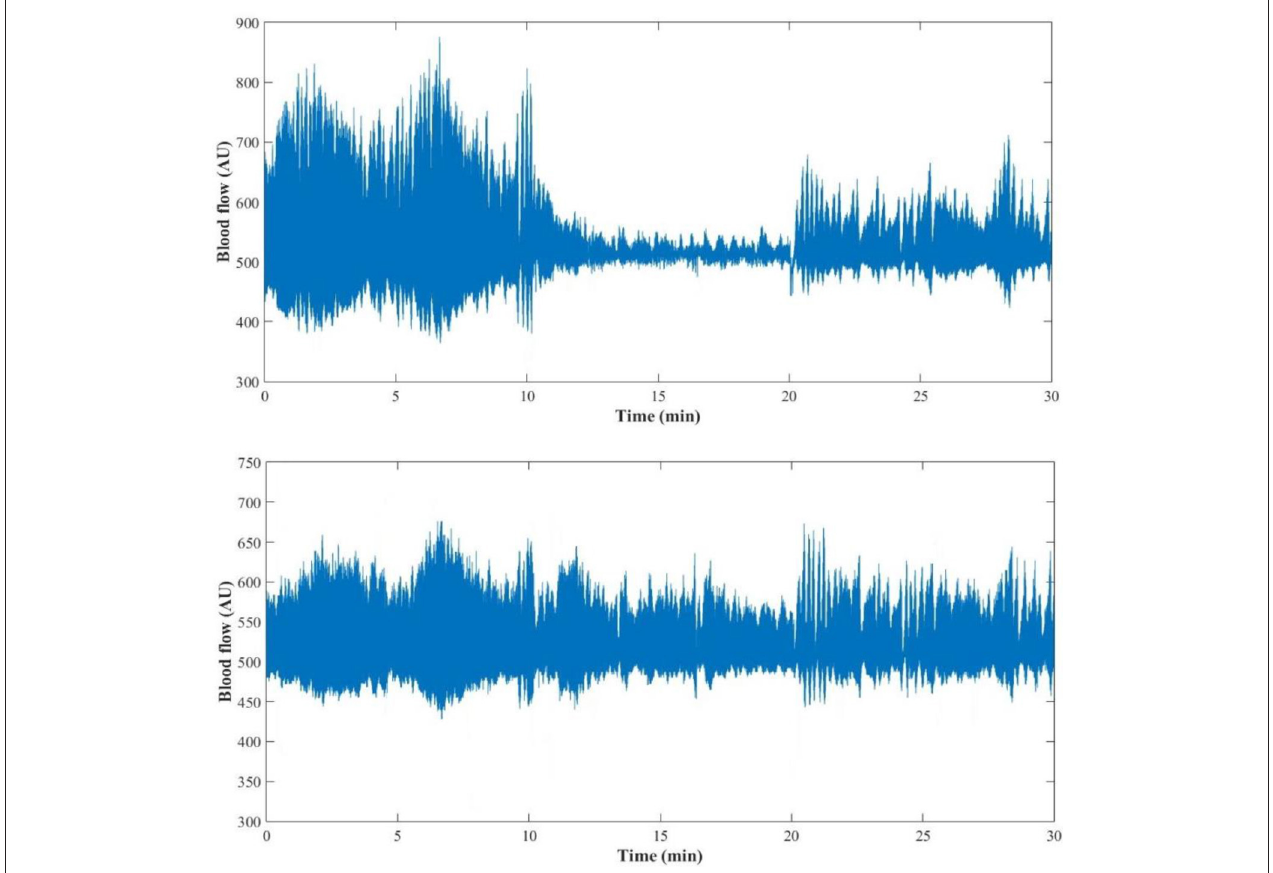
FIGURE 2 | PPG signal of one representative subject (female, 29 years old) during the 30min (baseline: 0–10min; challenge: 11–20min; recovery: 21–30min) protocol for the test (Top) and the control foot (Bottom) .